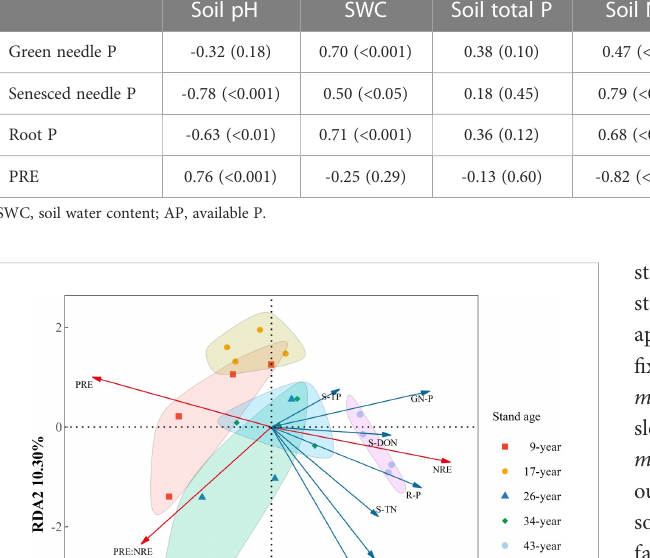
Senesced needle N